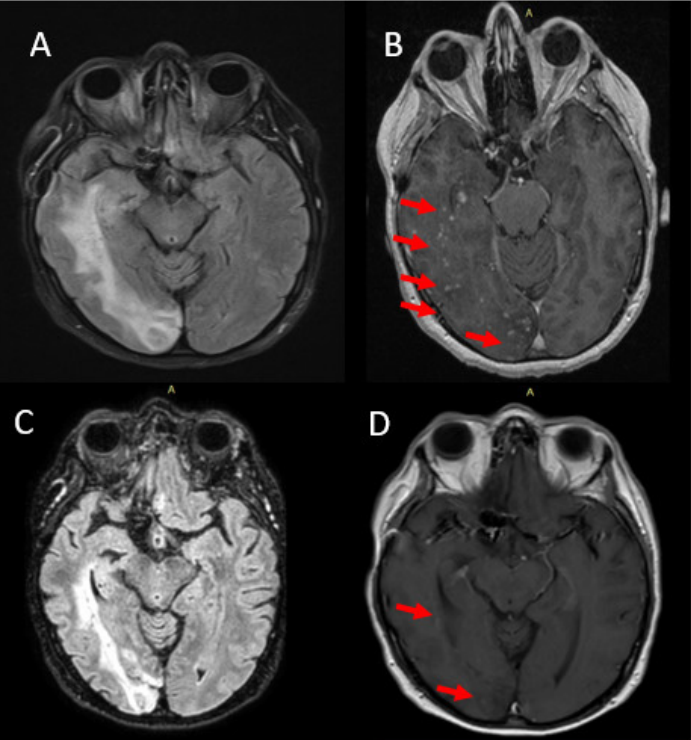
Figure 3. Imaging findings of case 2. White-matter hyperintensities right parietoccipital in axial FLAIR sequence (( A ); arrows); Gadolinium-enhancement of the lesions in axial T1-weighted image (( B ); arrows). Follow-up MRI one year later demonstrating slight vasogenic edema remission on axial FLAIR sequence ( C ); Significant improvement in axial T1-weighted image showing only slight Gd enhancement (( D ); arrows).